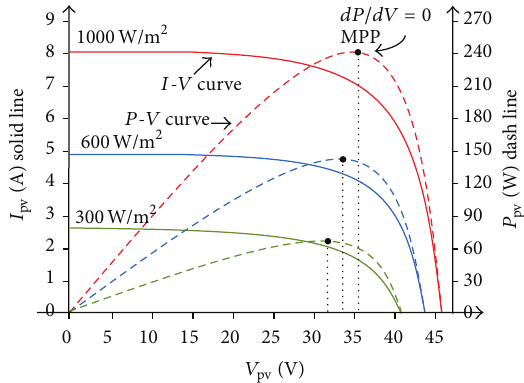
Figure 2: The 𝐼 ance levels. The maximum power point (MPP) occurring when the derivative dP / dV is